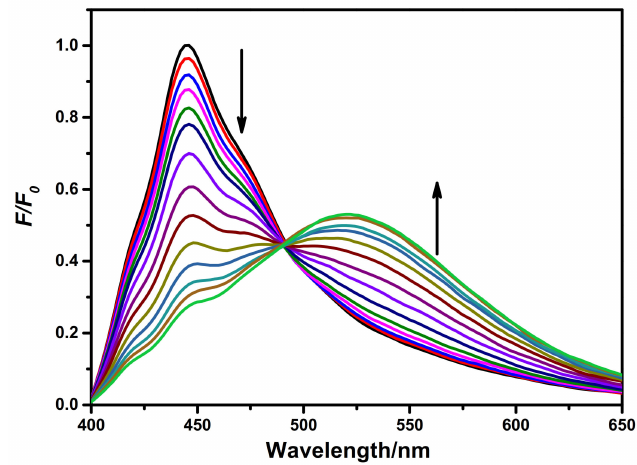
Figure 1. Fluorescence spectra (excited at 380 nm) of PMH (20 µ M) in the presence of various concentration of Hg 2 + ions (0–15 equiv.to PMH ) in acetonitrile / water (8:2, v / v , 0.1 M KNO 3 , pH =